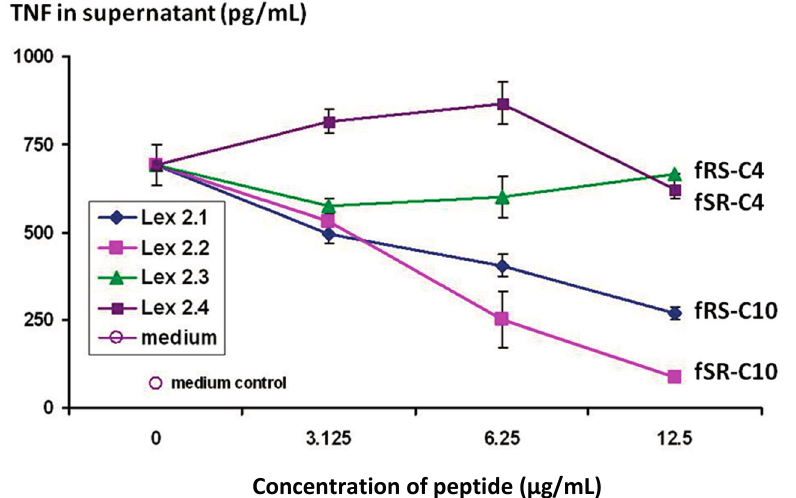
Figure 3. Changes in level of secretion of TNF into the supernatant of CTB-stimulated J774A.1 cells overnight after exposure to cyclic peptides as follows: Lex 2.1 and 2.2 are cyclo(-DF-R- Σ -S-DF-R- Σ -S-) and cyclo(-DF-S- Σ -R-DF-S- Σ -R-) respectively, where Σ represents an amino acid with a residue consisting of a straight C 10 hydrocarbon chain. Lex 2.3 and 2.4 are cyclo(-DF-R-Nle-S-DF-R-Nle-S-) and